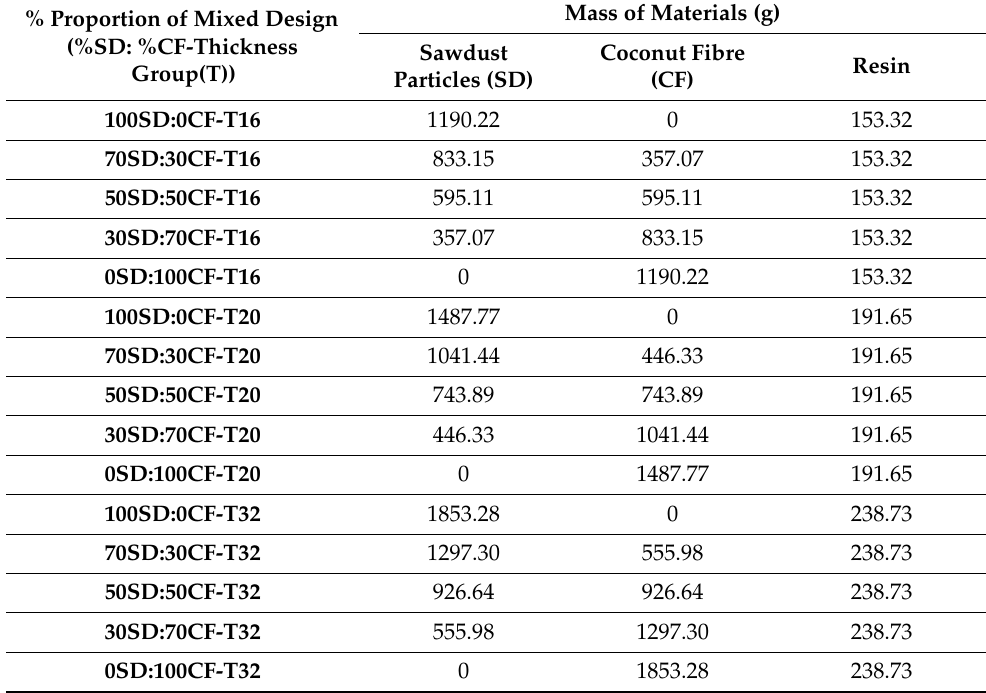
Table 2. Design Mixed of Board Sample According to Respective